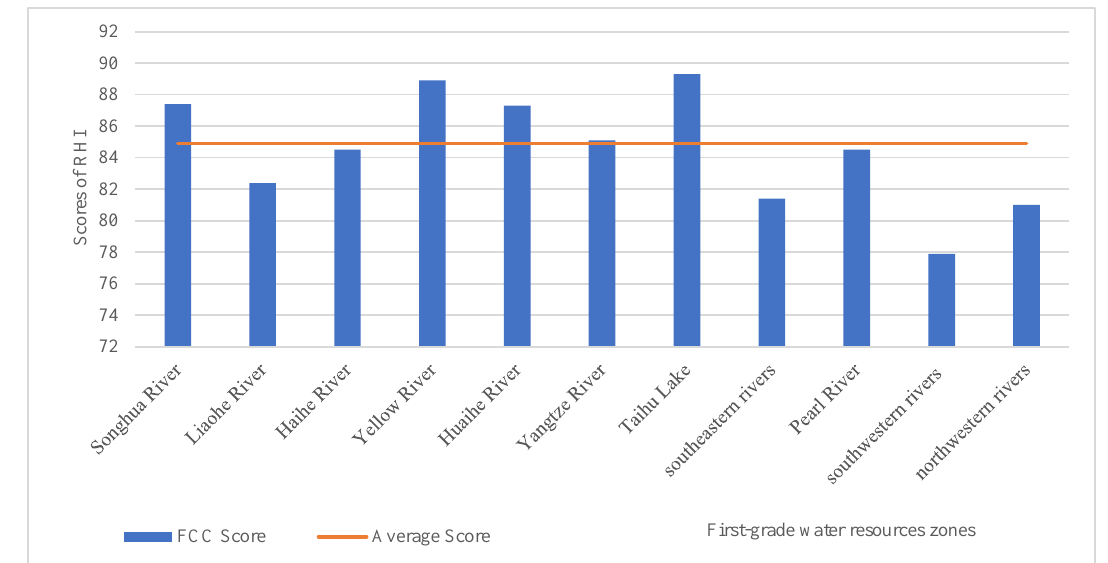
Figure 3. FCC evaluation results for China’s first -grade water resource zones.